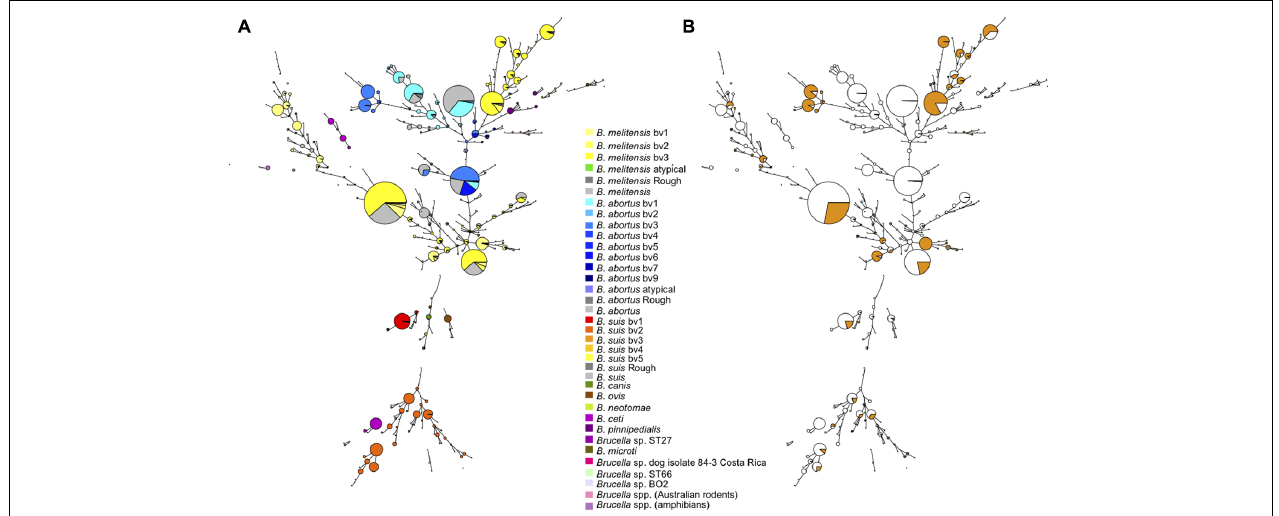
FIGURE 1 | Global view of the genetic diversity of Brucella spp. provided by MLVA11. Entries with a full MLVA11 dataset were used to produce a minimum spanning tree based upon 4998 entries, allowing hypothetical missing links. This includes 1404 Brucella strains from the present study, and 375 in silico deduced data (from 48 assemblies and 327 sequence reads archives). 377 MLVA11 genotypes are defined. (A) Strains are color coded according to species and biovar as indicated. (B) The proportion of strains from the present study is reflected by the colored sector in each circle.